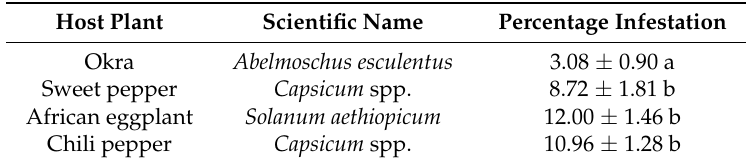
Table 3. Mean percentage of Thaumatotibia leucotreta larval infested vegetables sampled from fields near orange orchards in the mid-altitude growing region of